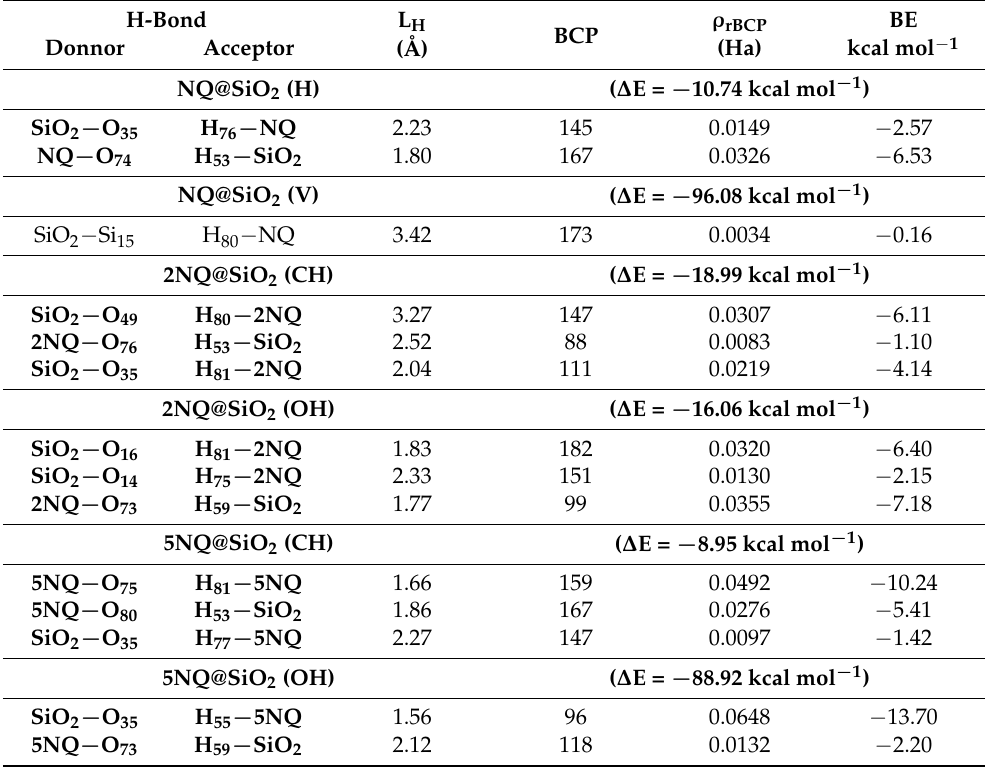
Table 3. Interaction energy ( ∆ E ), length of H-bond (L H ), bond critical point (BCP) index, all electron densities at BCP ( ρ rBCP ), and H-bond binding energy (BE) values obtained from interaction models. ρ rBCP BE H-Bond L H BCP Donnor Acceptor (Å) (Ha) kcal mol − 1 NQ@SiO 2 (H) ( ∆ E = − 10.74 kcal mol − 1 ) SiO 2 − O 35 H 76 − NQ 2.23 145 0.0149 − 2.57 NQ − O